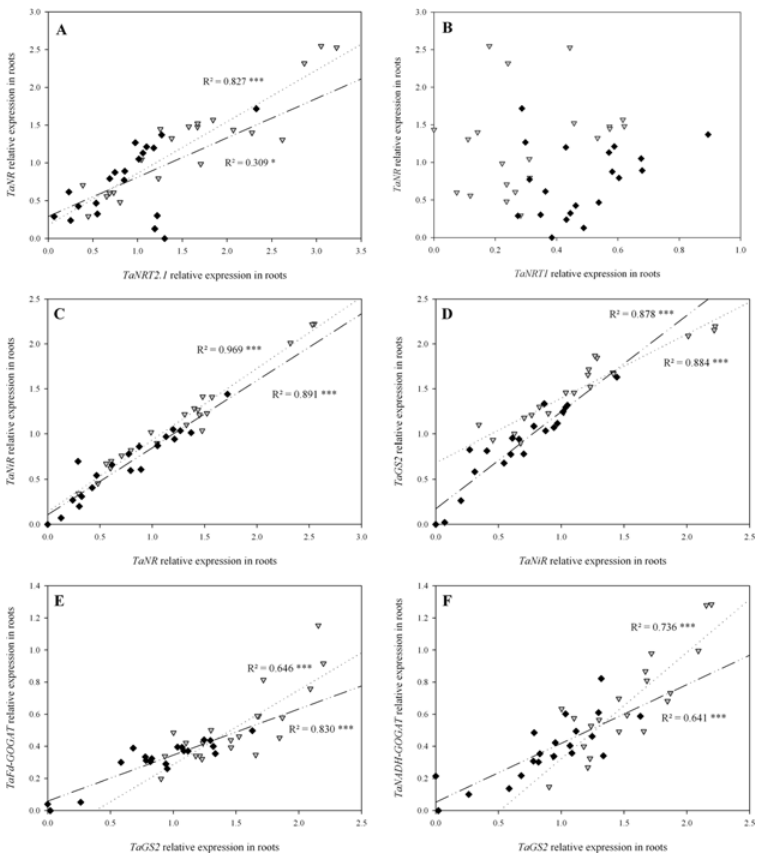
Fig 7. Correlations between relative expression patterns of the main genes involved in NO 3- uptake, reduction and assimilation in roots from flowering (GS65) to GS65+800DD for two contrasting NO 3- treatments (N4 and N10). Values originate from seven post-flowering sampling dates, each including three individual biological repetitions for N4 (grey triangles) and N10 (black diamonds). Relations are for (A) TaNRT2 . 1 and TaNR , (B) TaNRT1 and TaNR , (C) TaNR and TaNiR , (D) TaNiR and TaGS2 , (E) TaGS2 and TaFd-GOGAT , and (F) TaGS2 and TaNADH-GOGAT . Quantification was performed by qRT-PCR. Relative expression values were calculated using the Δ CT method corrected for primer efficiency, using Ta54280 and Ta54948 as internal controls. Statistical analyses were by the Pearson correlation